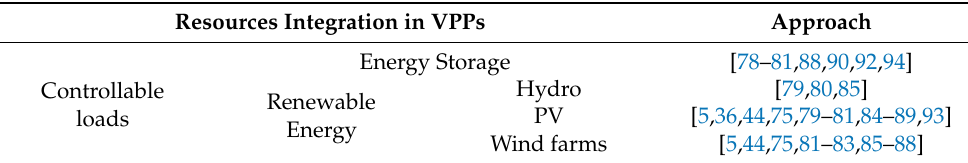
Table 4. Energy resources coordination in VPP for energy autonomy.